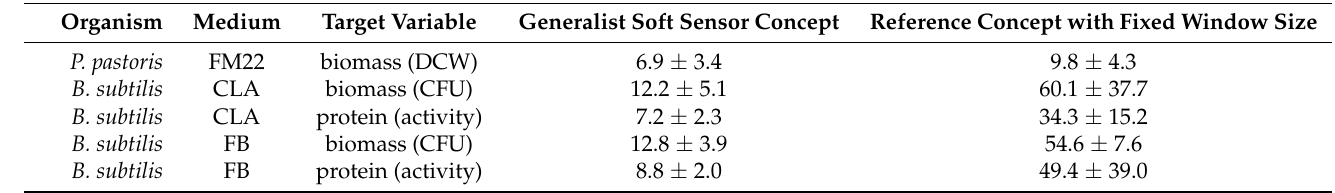
Table 1. Comparison of the relative root mean square errors of the generalist soft sensor concept and the reference concept with fixed window size of 20 h for biomass prediction of the P. pastoris process and the biomass and product prediction of a B. subtilis process in two different cultivation media. Five random data sets each were used for validation. DCW = dry cell weight; CFU = colony forming